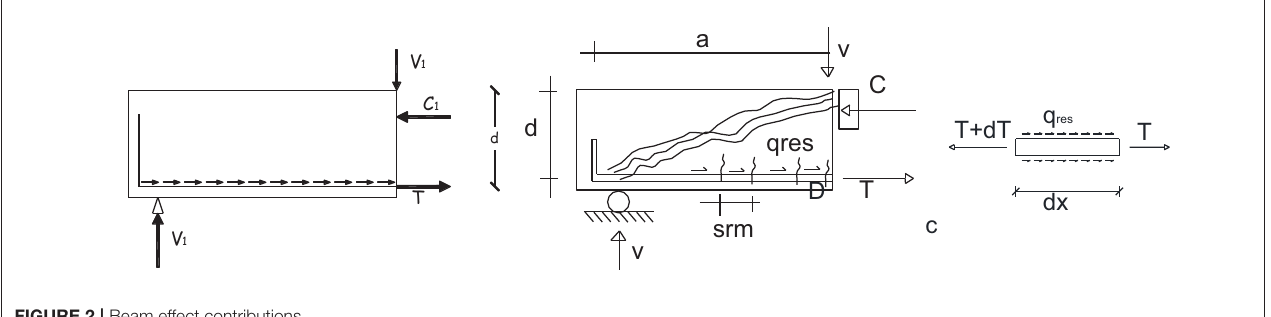
FIGURE 2 | Beam effect